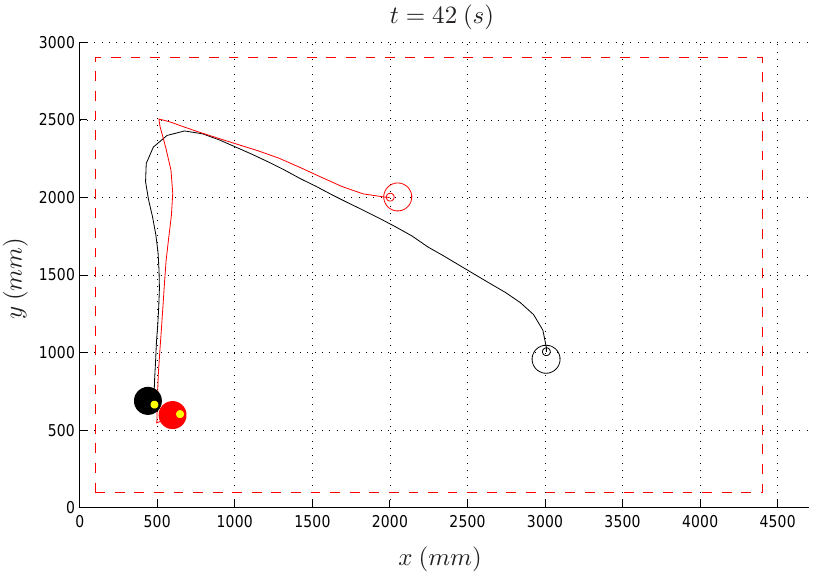
Figure 12. Pursuer-evader games, Algorithm 1: pursuer (black) and evader (red) with a PE speed ratio equal to 80%.